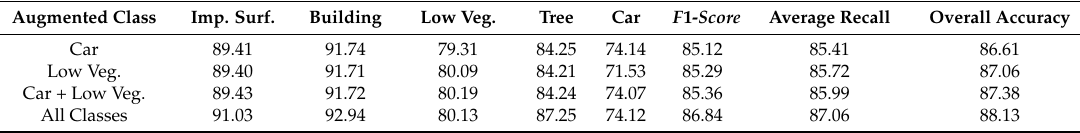
Table 10. Result of augmentation in different